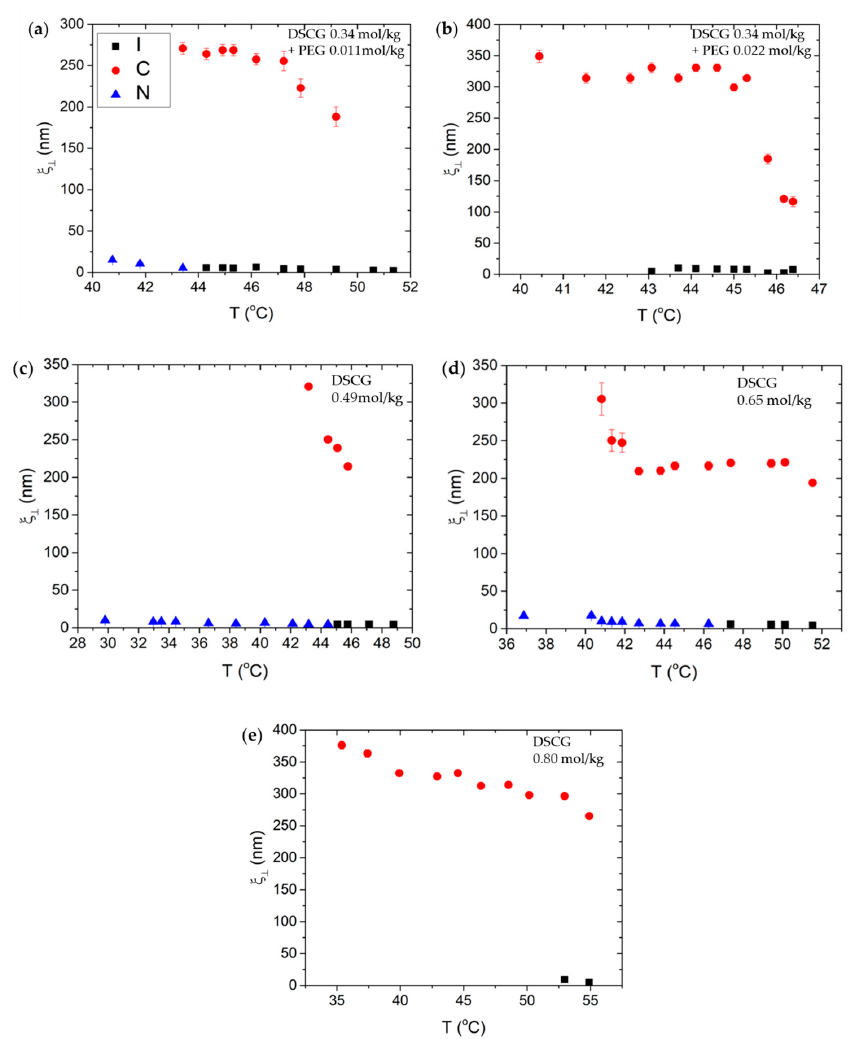
peaks; I peak (blue dotted line), C peak (red dotted line), and I + C peak (green dotted line).